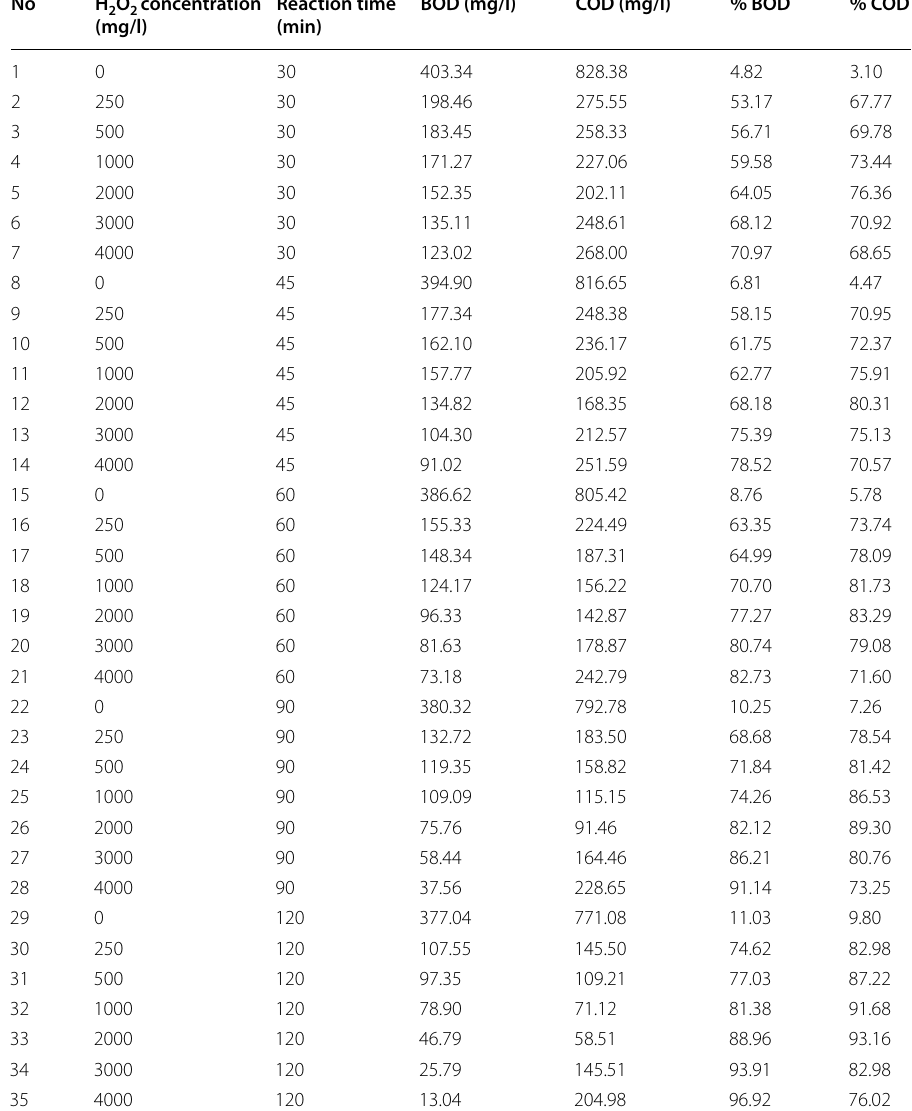
Table 2 Experimental design and obtained